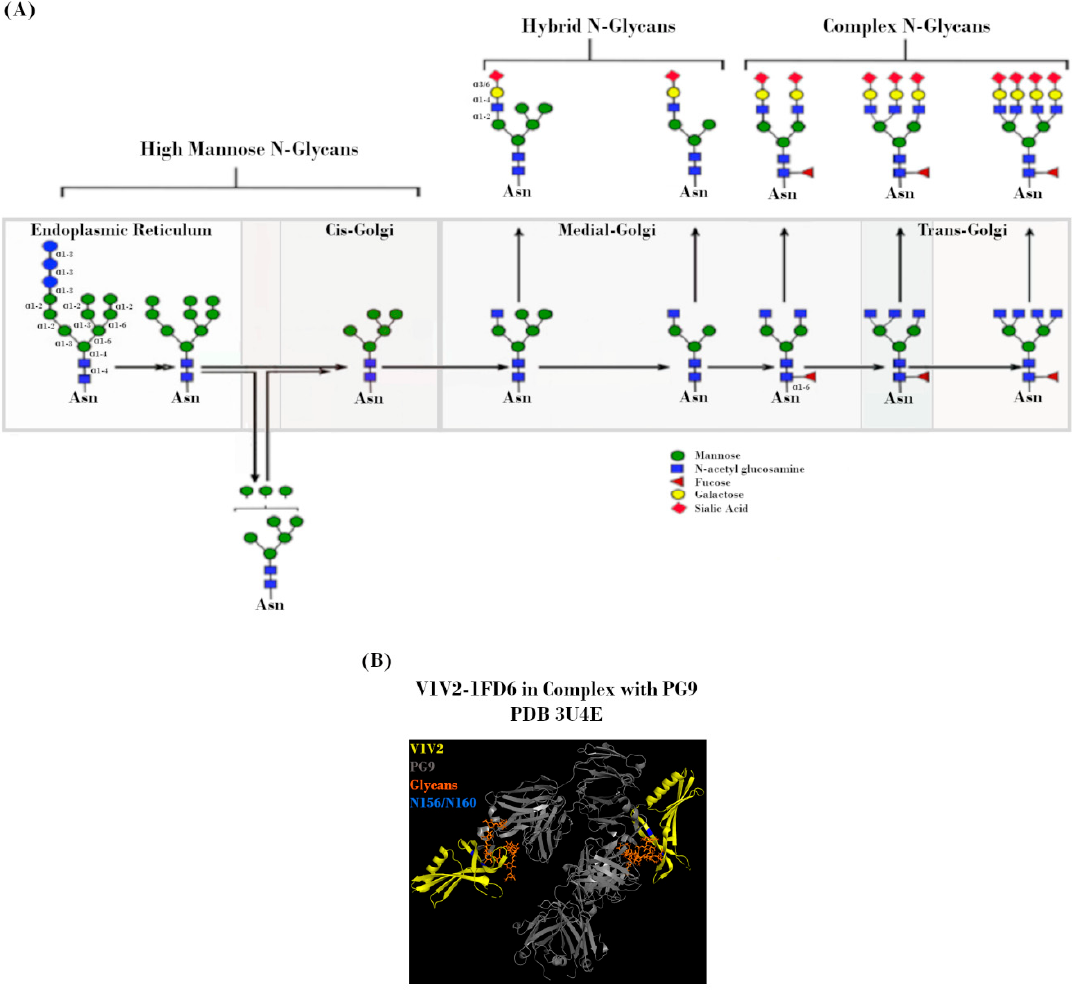
Figure 3. N-linked glycans on the HIV-1 envelope (Env). ( A ) Potential N-linked glycosylation site (PNGS) occupancy is initiated via the placement of a Glc 3 Man 9 GlcNAc 2 residue, which is subsequently modified during transit through the endoplasmic reticulum (ER) and Golgi by a milieu of host enzymes to yield its final glycoform. Figure adapted from Jan et al., 2019 [49]. ( B ) Crystal structure (2.19 Å) of PG9 mAb in complex with V1V2 region from HIV-1. Regions corresponding to V1V2 (yellow), PG9 (grey), PNGS N156 and N160 (blue), and N-glycans (orange) are indicated. Protein Data Bank identifier (PDB ID) number is also indicated. Adapted from McLellan et al., 2011 [50].